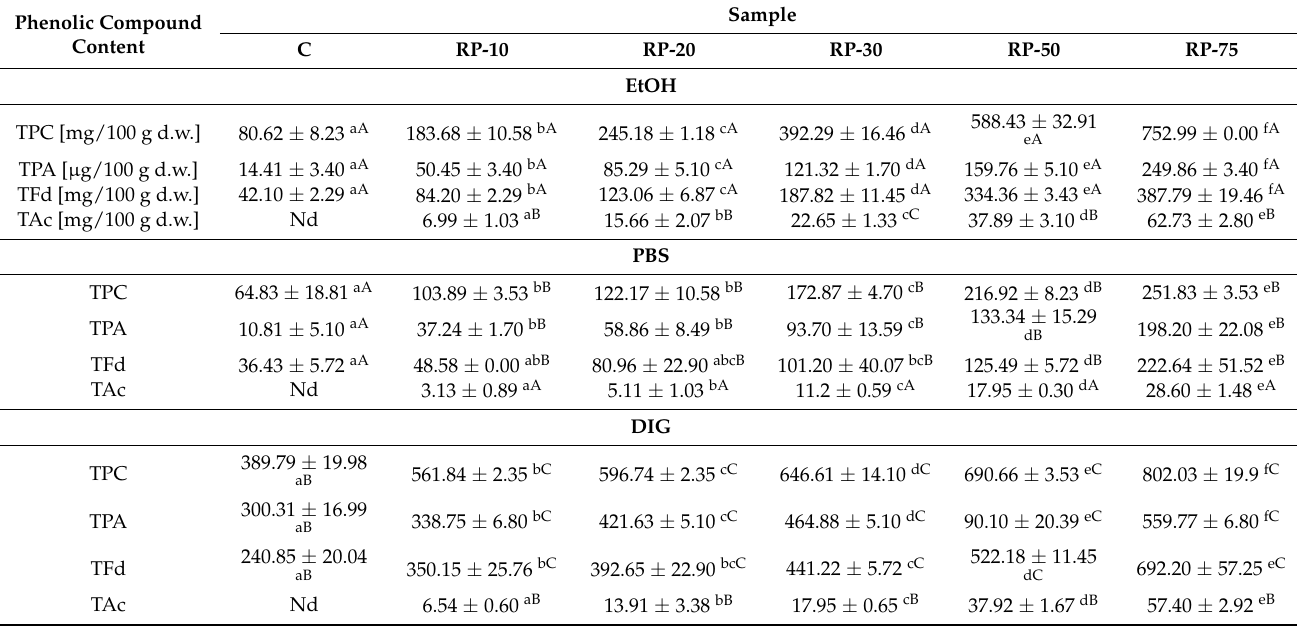
Table 4. Comparison of the phenolic compound content in different extracts from control and fortified